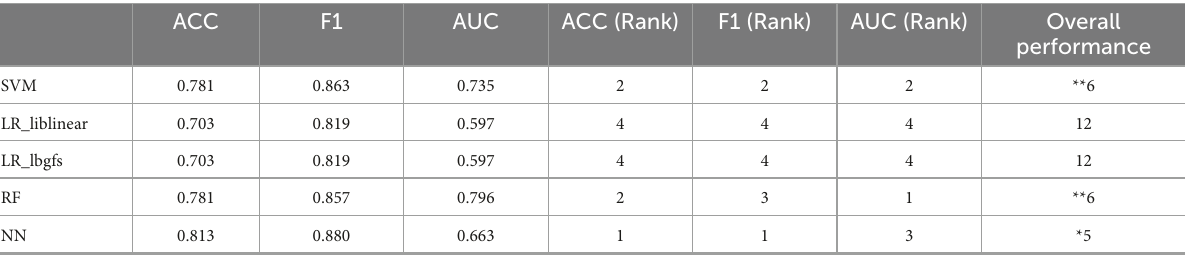
TABLE 2 Model evaluation